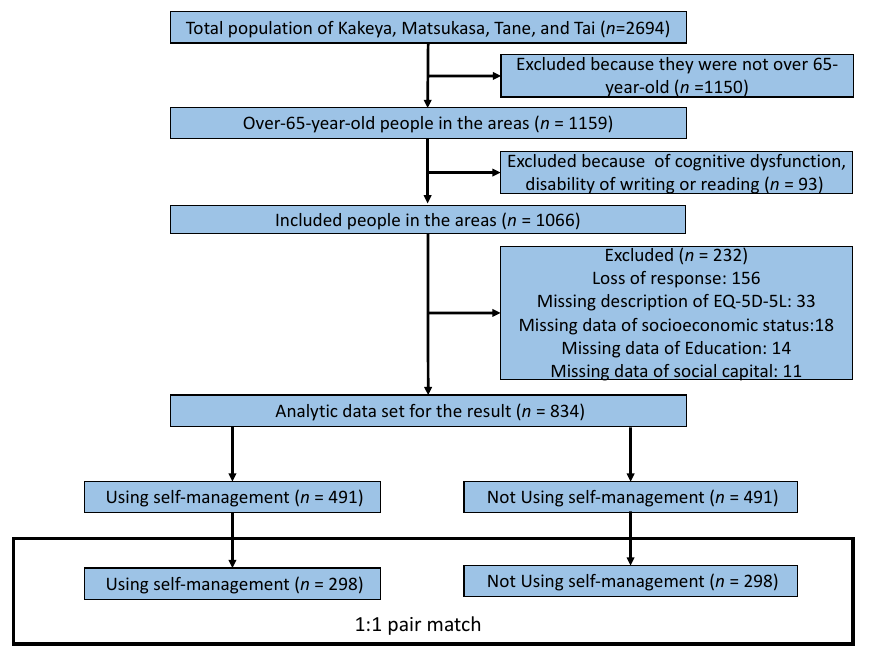
Figure 1. Flowchart of the participant selection process.